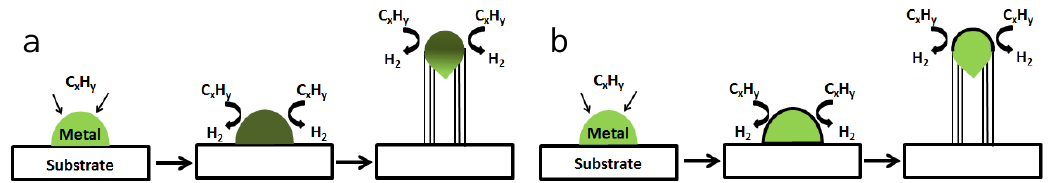
Figure 3. Growth mechanisms for CNTs based on the state of metal catalyst and the diffusion way of carbon: ( a ) VLS mechanism and ( b ) VSS mechanism.